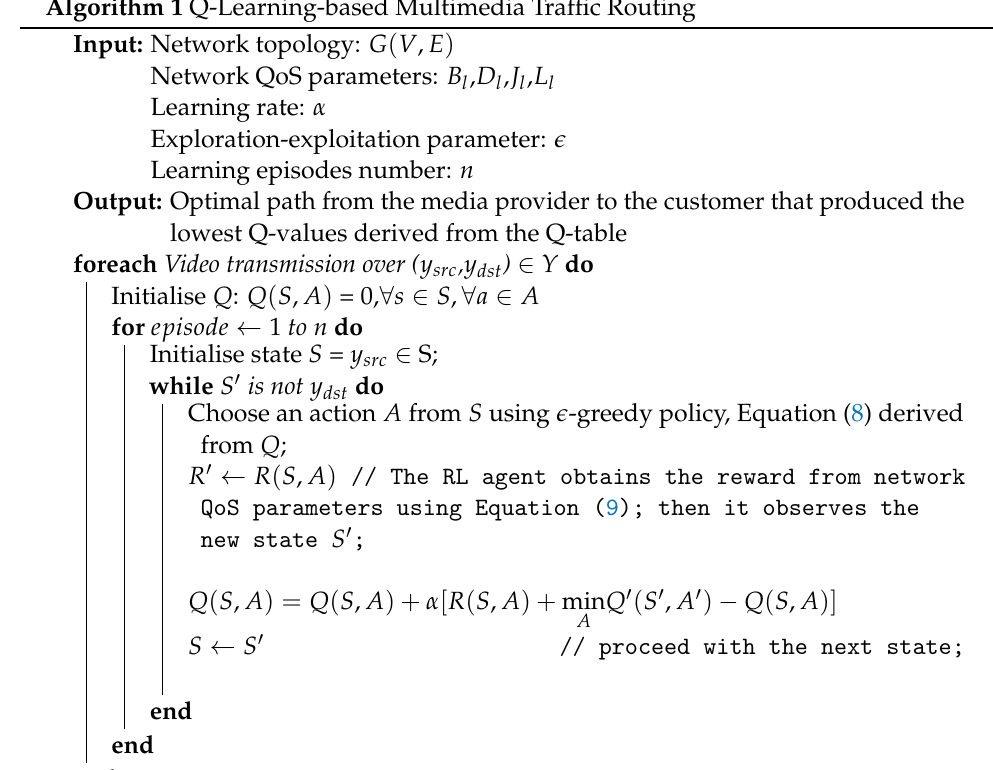
Algorithm 1 Q-Learning-based Multimedia Traffic